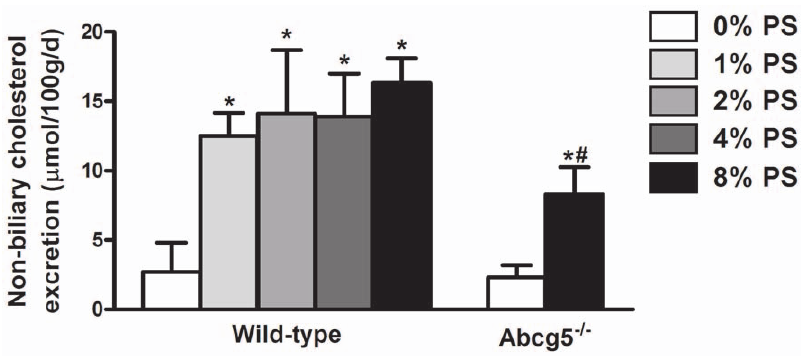
Figure 3. Non-biliary cholesterol excretion in wild-type and Abcg5 -/- mice fed mice fed either control or diet enriched with varying doses of plant sterols. Values represent average 6 SD. n=4–11. * P , 0.05 control vs plant sterol fed wild-type mice; # P , 0.05 control vs plant sterol fed Abcg5 -/- mice.